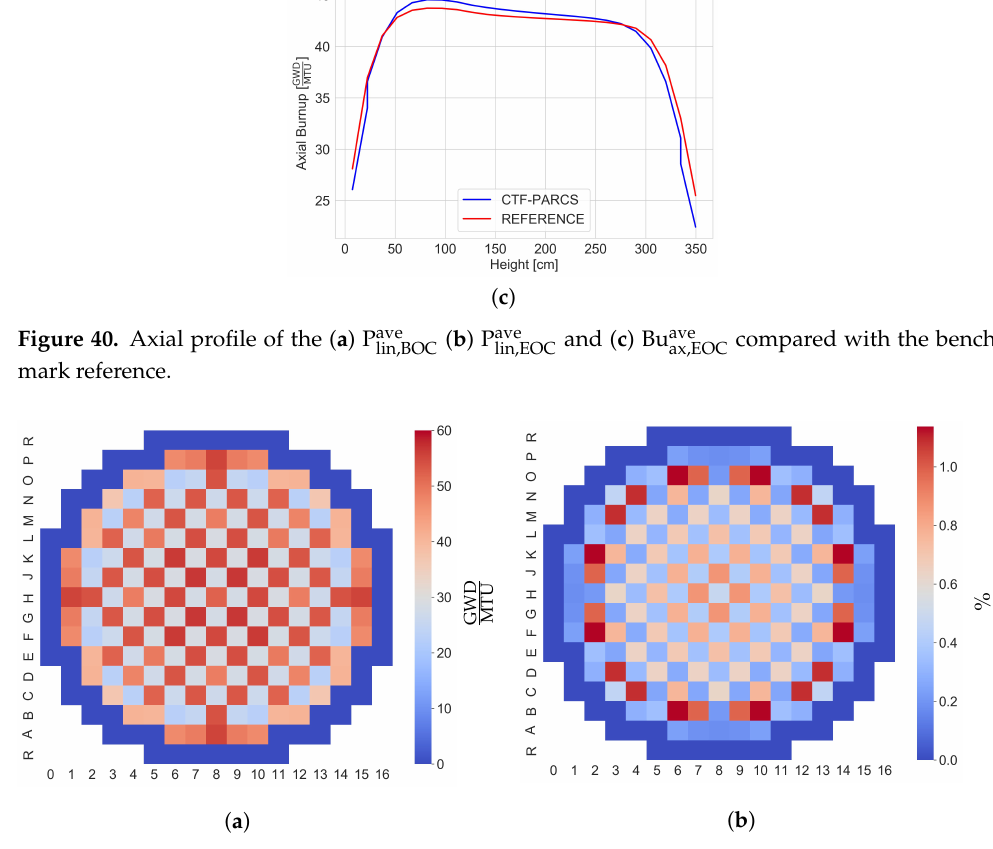
( a ) mean and ( b ) standard deviation at the EOC. rad,EOC